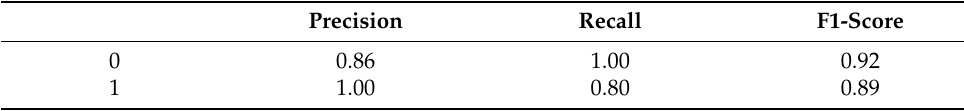
Table 11. Performance Metrics for Testing